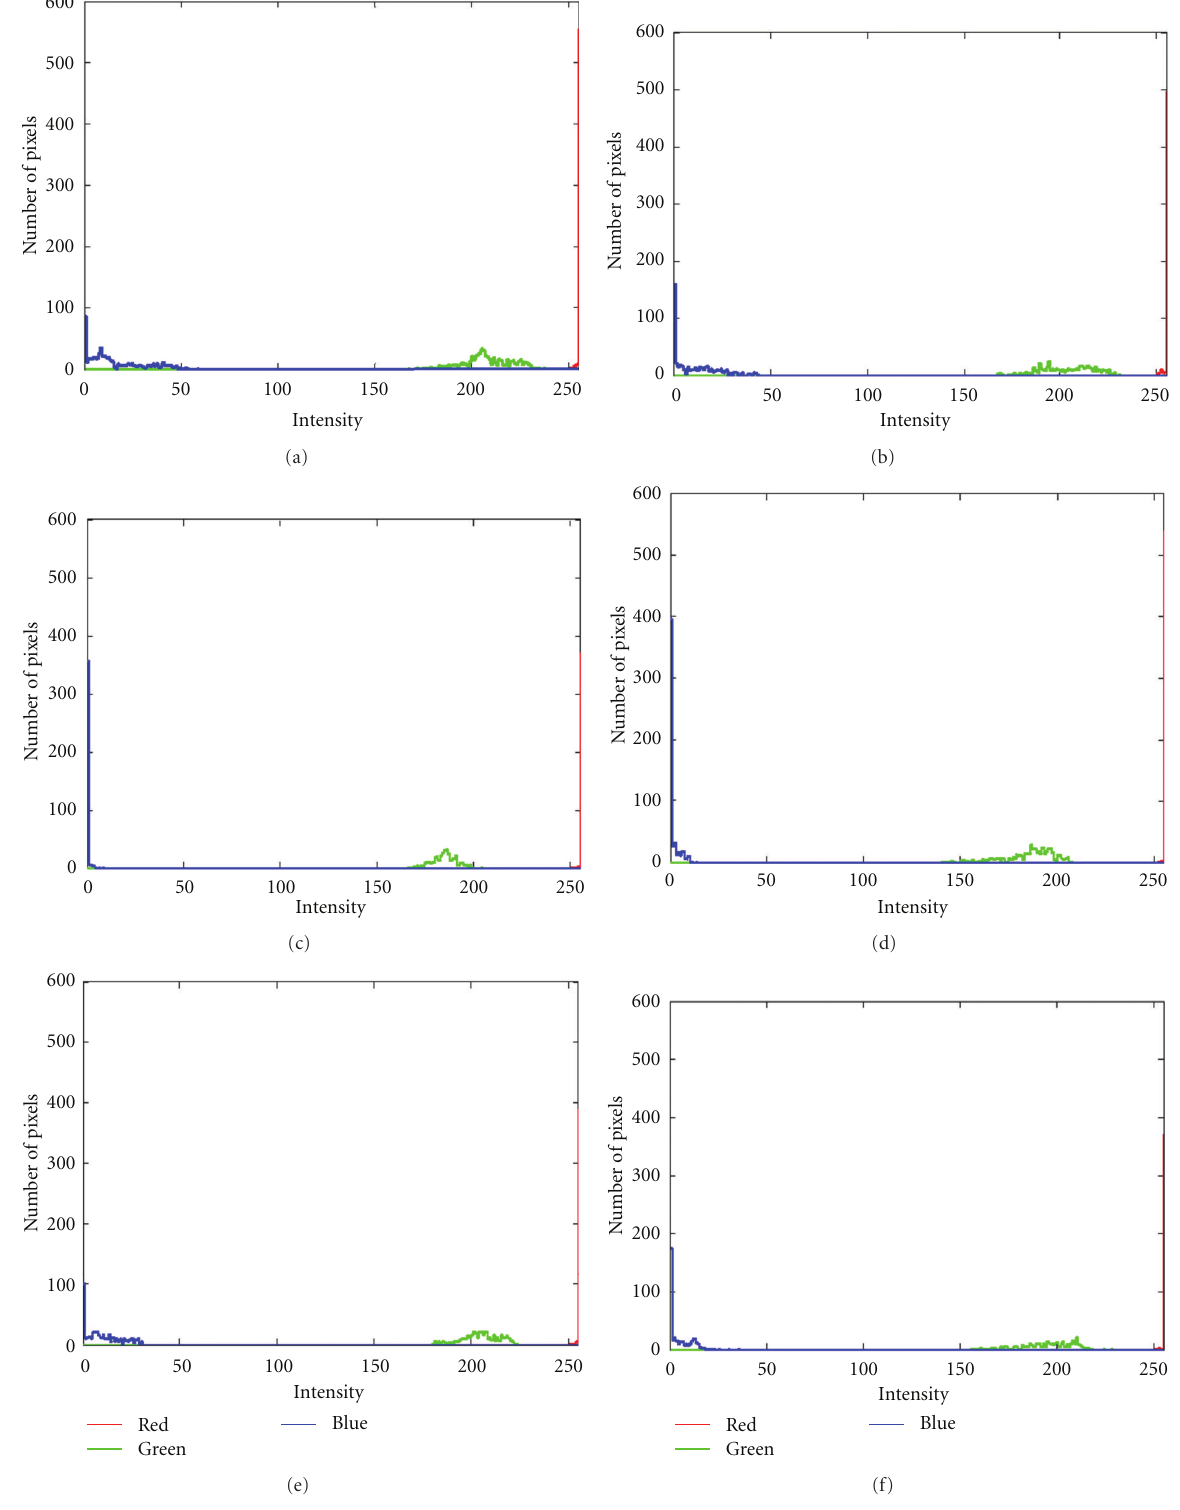
Figure 5: RGB histogram of single rat (control group II) thermal image in di ff erent regions (a) lower right flank region, (b) lower left flank region, (c) right abdomen region, (d) left abdomen region, (e) right shoulder region, and (f) left shoulder region. Red, blue, and green pixel distributions were symmetrical between right and left sides in all the regions (flank, abdomen, and